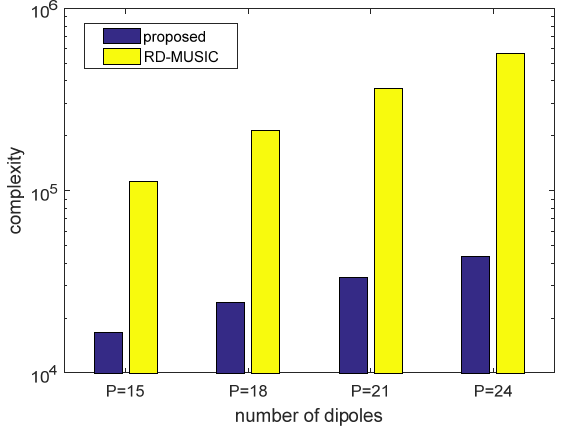
Figure 6. Complexity comparison.